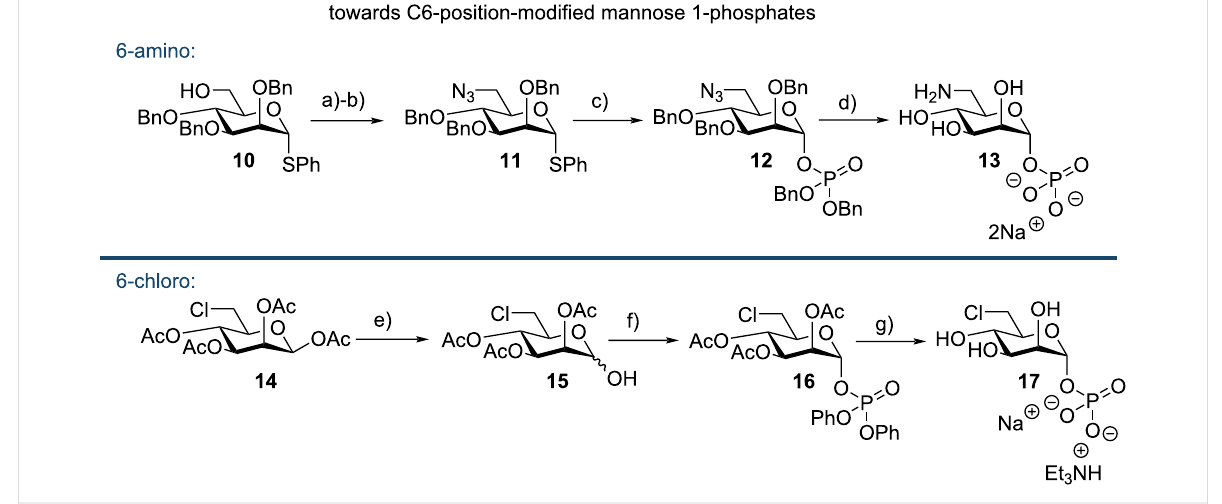
Scheme 1: Syntheses of C6-modified mannose 1-phosphates 13 and 17 . Conditions a) PPh 3 , CBr 4 , DCM, rt, 75%; b) NaN 3 , DMF, 75 °C, 64%; c) HO(O)P(OBn)